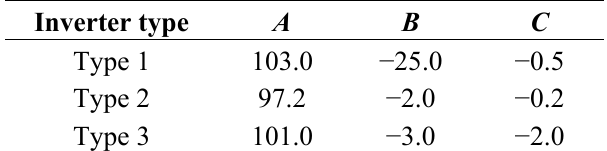
Figure 7. Example of three typical per unit efficiency curves for grid-connected solar inverters. Table 3. Example of A , B , C coefficients of 3 solar inverter topologies.